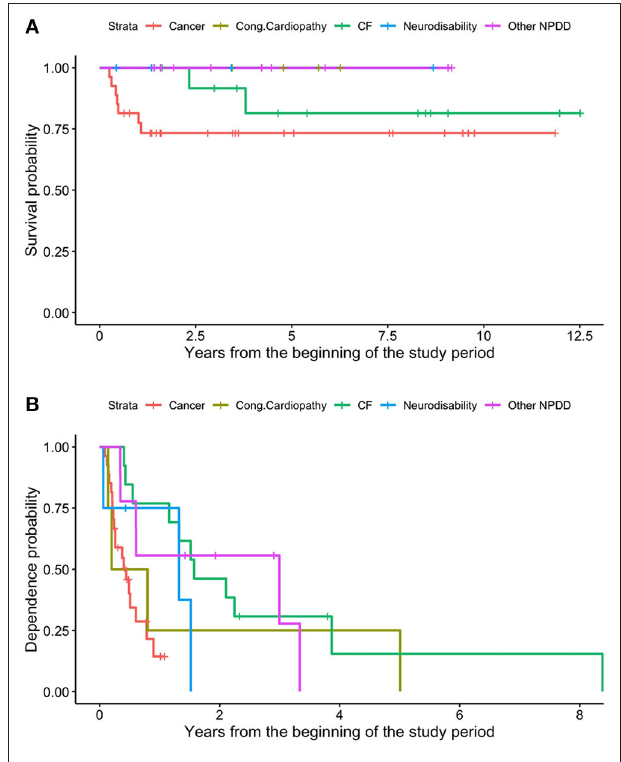
FIGURE 6 | Survival (A) and dependence (B) rates of patients on HPN because of secondary CIF.